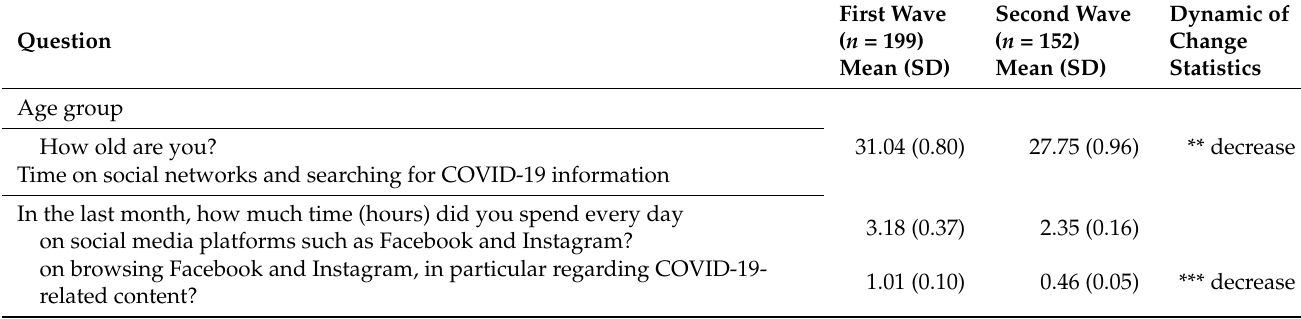
Table 1. Age group and social media use.